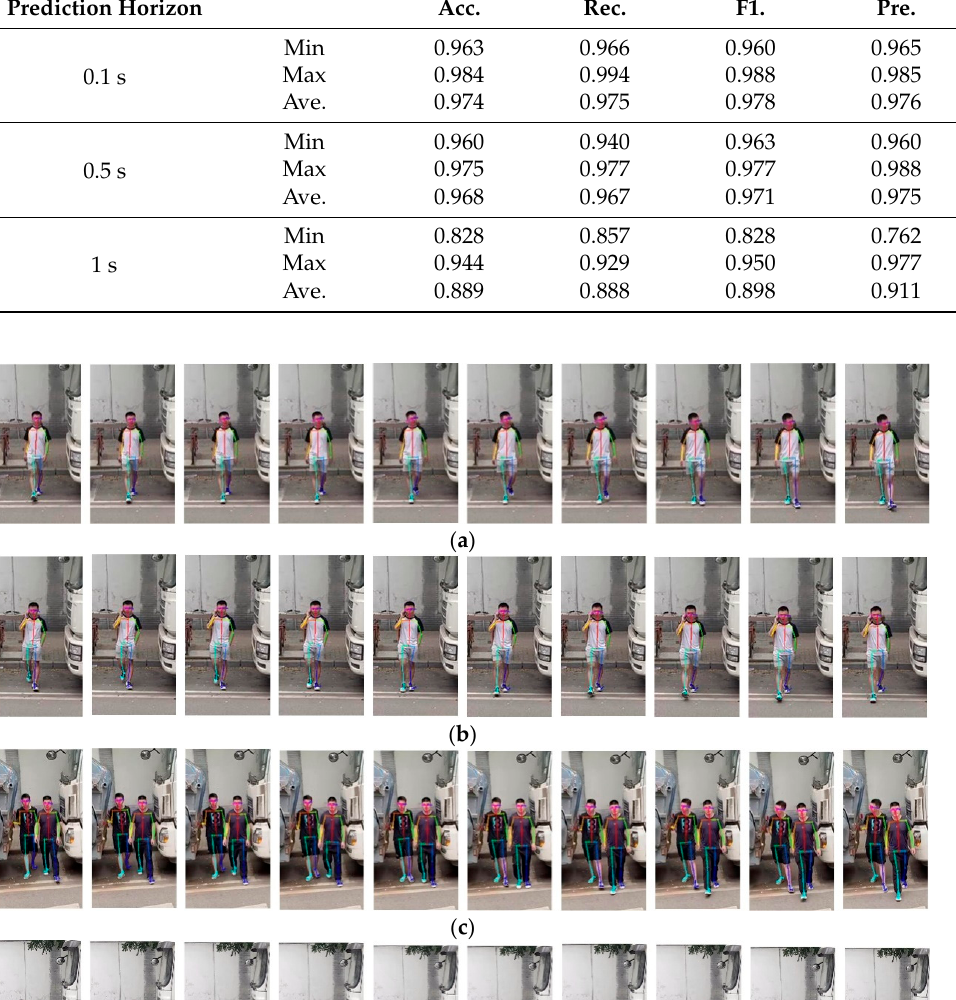
Table 7. Prediction results for different time horizons. Prediction Accuracy (Acc.), Recall (Rec.), F1-score (F1.), Precision (Pre.). Min, Max, and Average (Ave.) results. Prediction Horizon Acc. Rec.